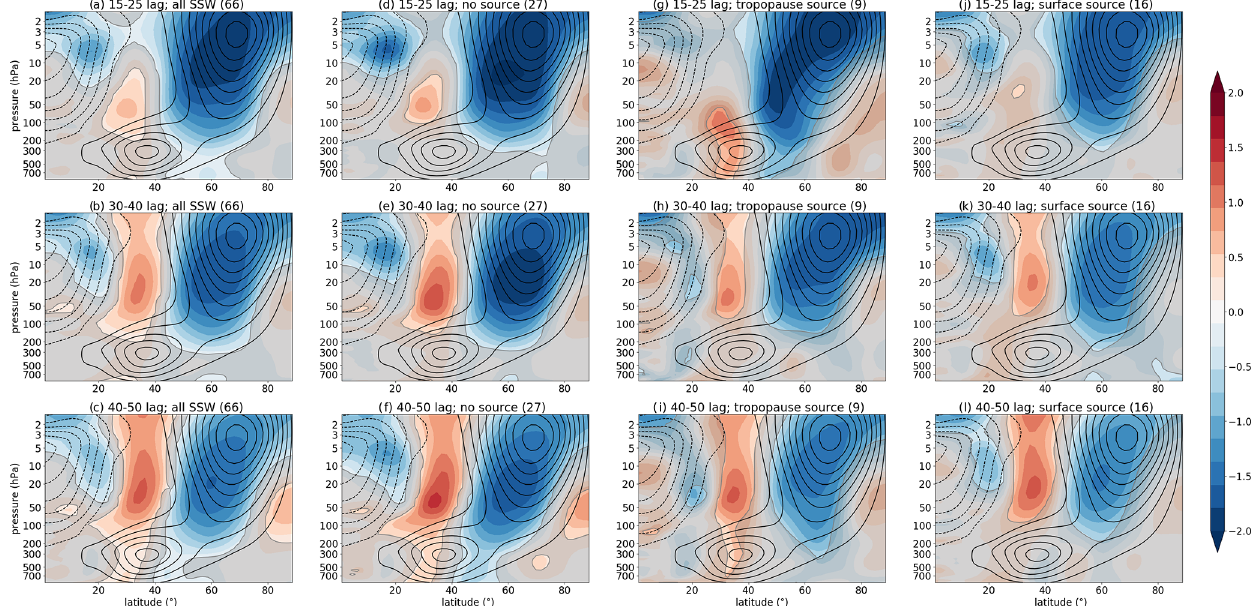
Figure 8. Composite analysis of downward impact in zonal mean zonal wind (latitude–pressure vertical cross section) averaged between the lags of 15 and 25d (a, d, g, j) , 30 and 40d (b, e, h, k) , and 40 and 50d (c, f, i, l) following (a–c) all SSW events, (d–f) SSWs not preceded by any wave-source events, (g–i) SSWs preceded by tropopause wave source, and (j–l) SSWs preceded by a surface wave source. The figure shows standardized zonal mean zonal wind anomalies (shading) and zonal mean zonal wind climatology (contours; contour interval is 5ms − 1 with the zeroth contour omitted for clarity, i.e...., − 10, − 5, 5, 10,...). Grey shading masks out data that are not significant at the 95% level. Numbers in brackets denote the number of events in each composite. Data are from the model.